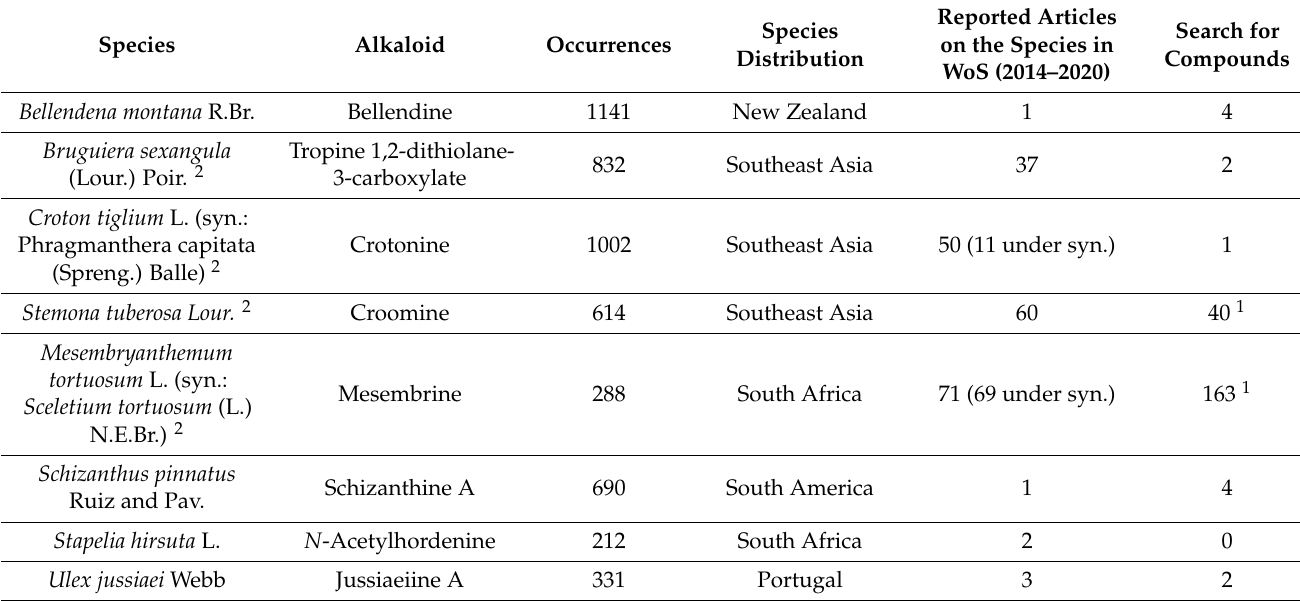
Table 4. Simple alkaloids with low chemo-diversity (a low count in GBIF occurrences) and number of reported published research articles on species from Web of Science between 2014 and 2020. 1 Majority of the studies on the compounds focuses on chemical synthesis (>50%) 2 Used as traditional medicine. Reported Articles Search for Species on the Species in Species Alkaloid Occurrences Compounds Distribution WoS (2014–2020) Bellendena montana R.Br. Bellendine 1141 New Zealand 1 4 Bruguiera sexangula Tropine 1,2-dithiolane- 832 Southeast Asia 37 3-carboxylate Crotonine 1002 Southeast